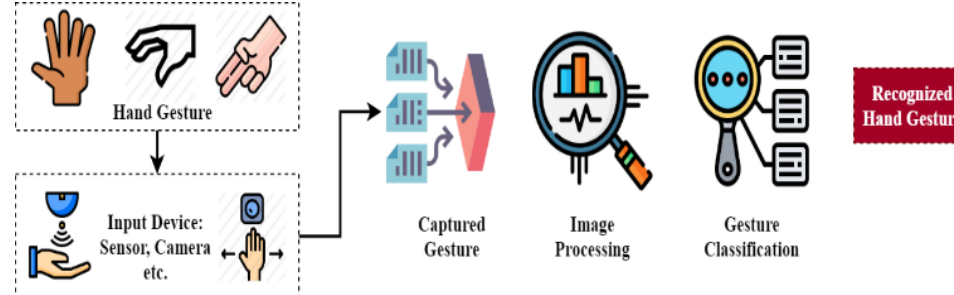
Figure 5. General framework about hand gesture recognition.